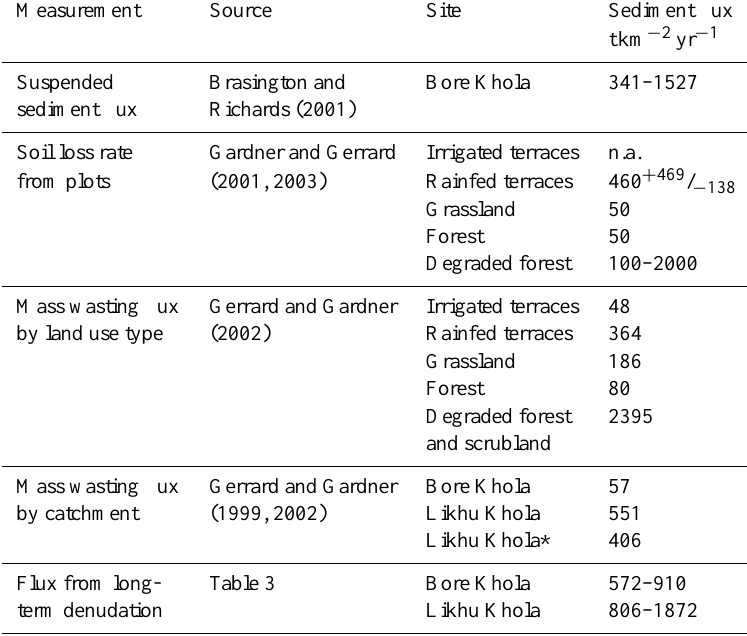
Table 4. Summary of erosional fluxes measured in the Likhu